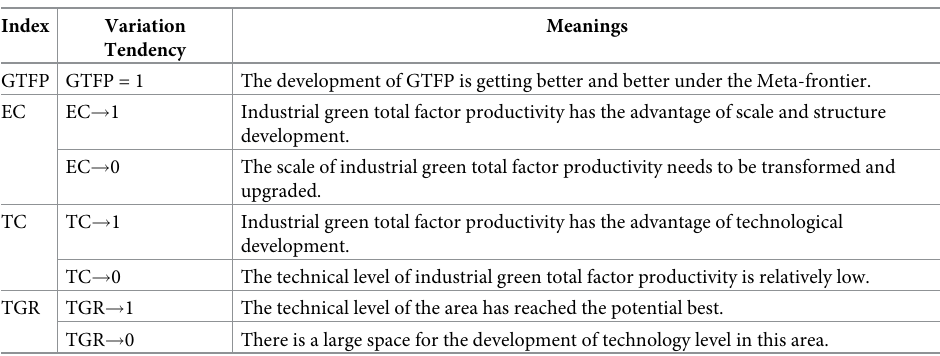
Table 1. Meanings of